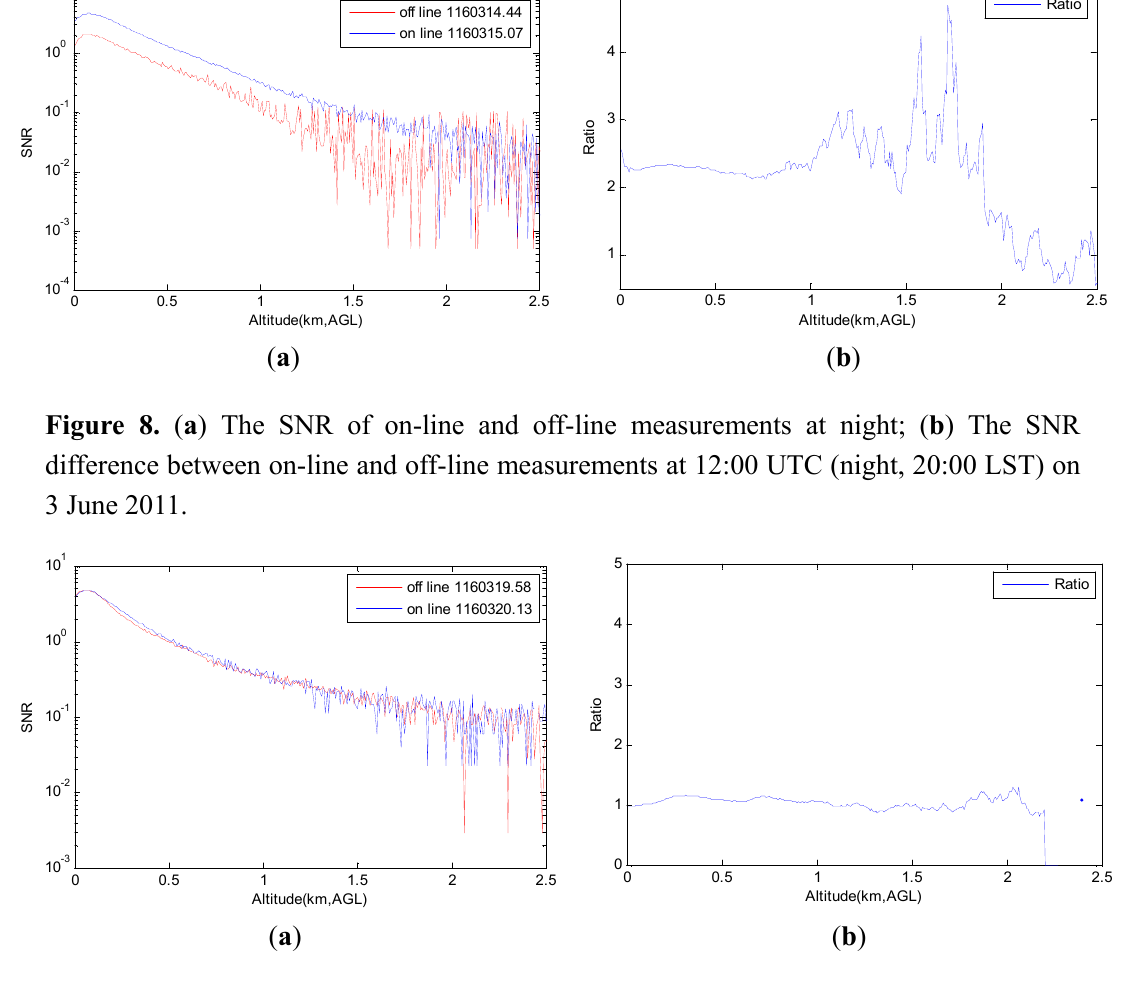
Figure 7. ( a ) The SNR of on line and off line measurements; ( b ) The SNR difference between on-line and off-line measurements, at 07:00 UTC (daytime 15:00 LST), on 3 June 2011.